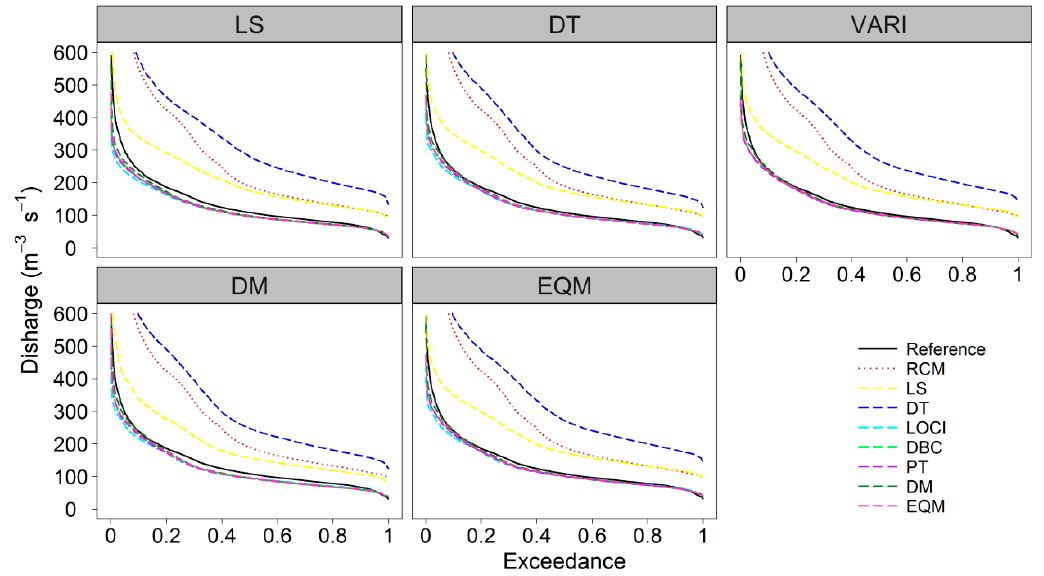
Figure 10. Exceedance probabilities of discharge between 1986–2004 periods grouped by temperature bias-corrected methods.